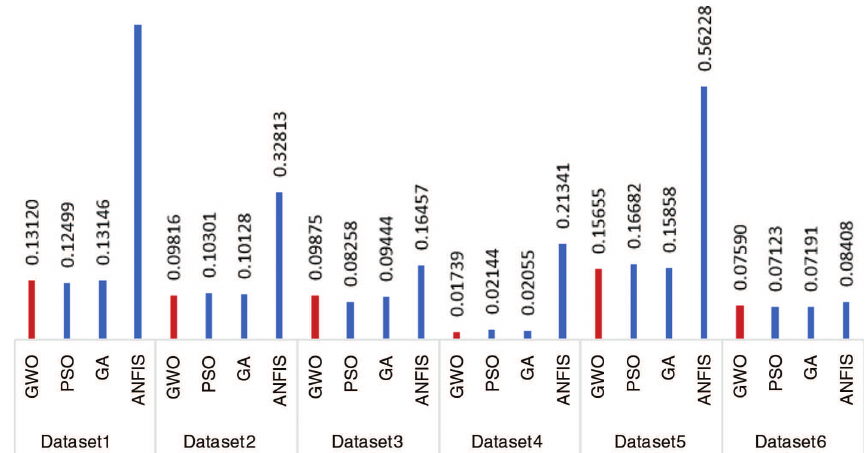
Figure 5: Results of the MAE Measures.